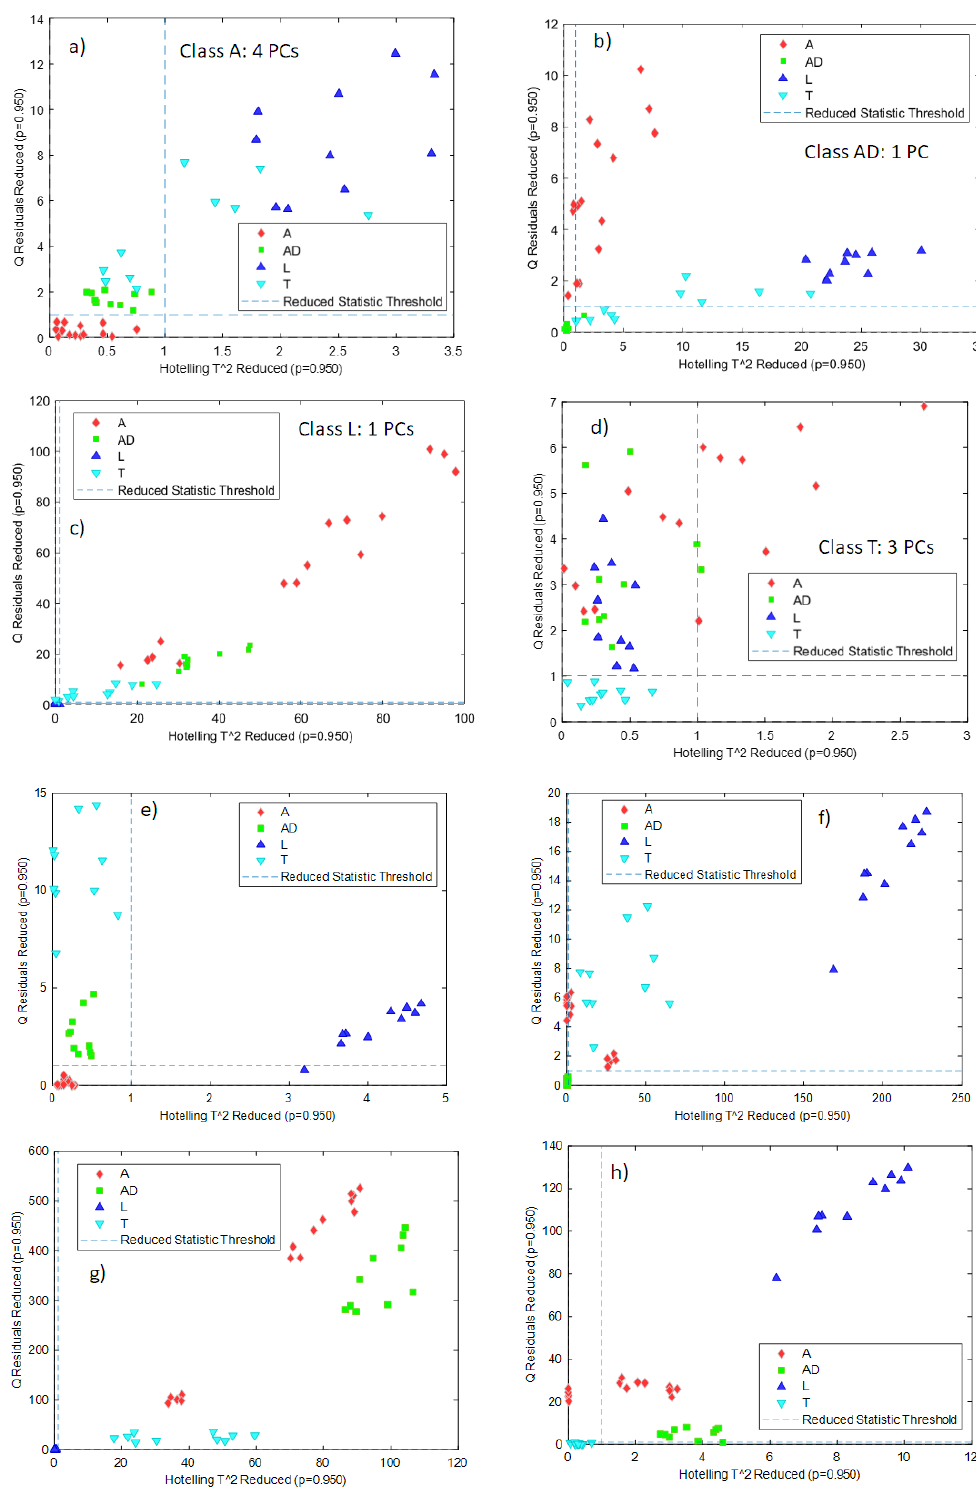
Figure 4. Projection of samples of other classes onto the Hotelling’s T 2 and Q confidence intervals for the individual PCA models built for each class: ( a ) class A NeoSpectra MDK data, ( b ) class AD NeoSpectra MDK data, ( c ) class L NeoSpectra MDK data, ( d ) class T NeoSpectra MDK data), ( e ) class A SCiO data, ( f ) class AD SCiO data, ( g ) class L SCiO data, ( h ) class T SCiO data. Results are without differentiating grinding level or producer.